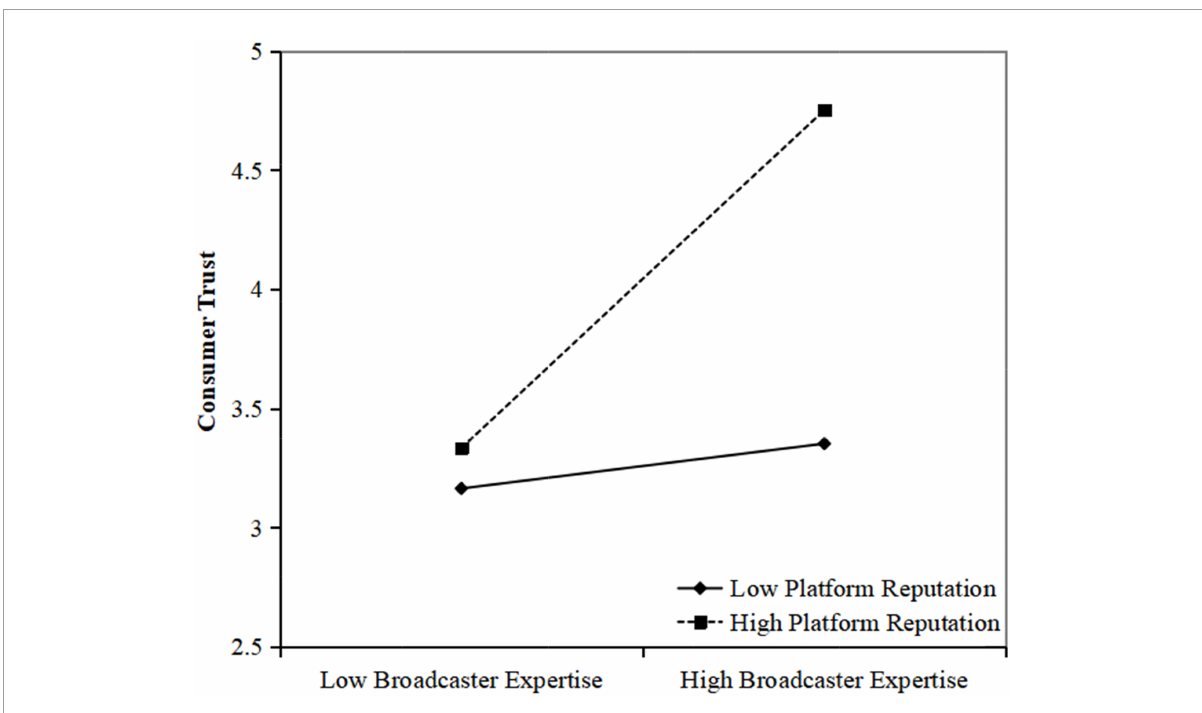
FIGURE2 Interaction of broadcaster expertise and platform reputation on consumer